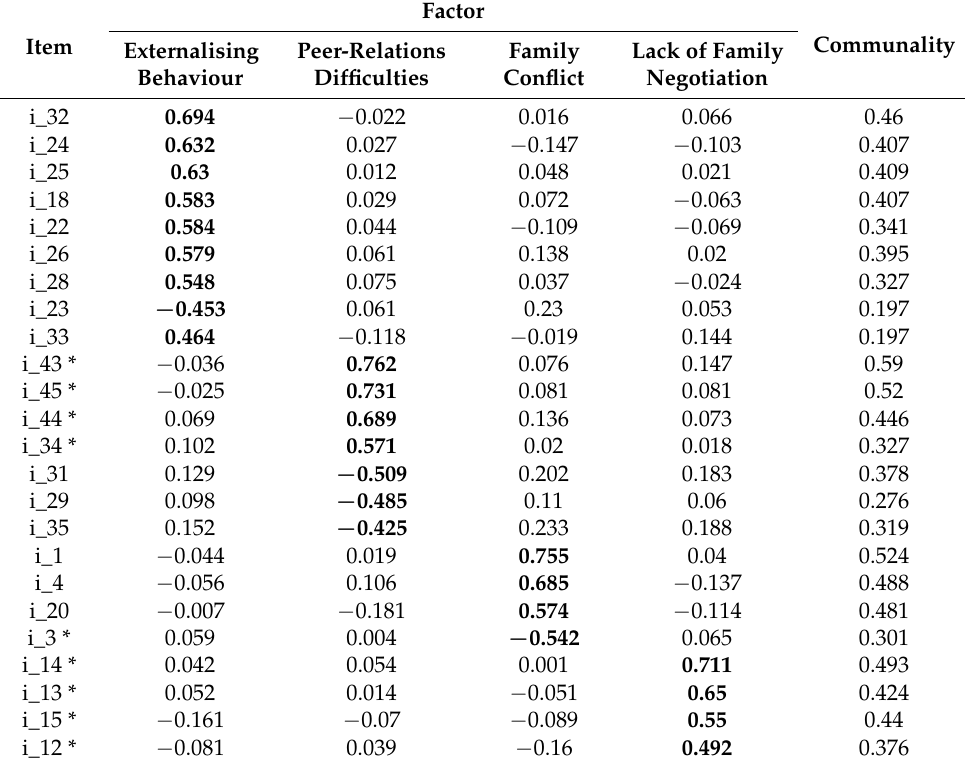
Table 1. FPEB: Final results of Principal Axis Factor Analysis (Promax Rotation); N =